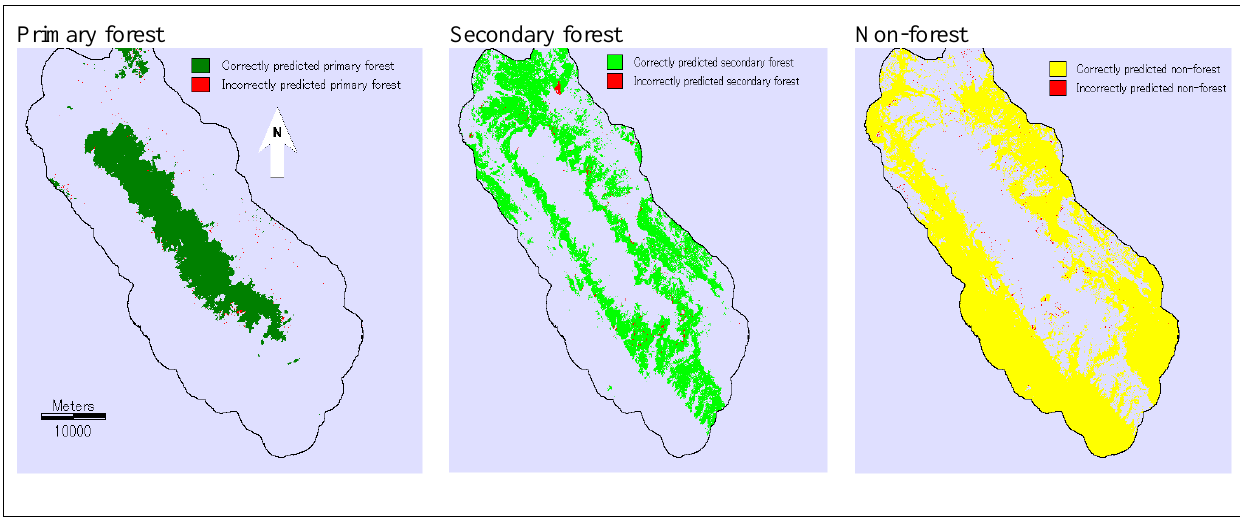
Figure 10. Correctly and incorrectly predicted areas of the predicted forest cover map in